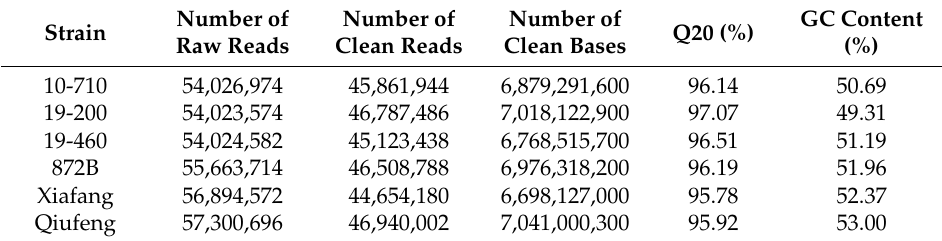
Table 3. Summary of the sequence assembly after lllumina sequencing.